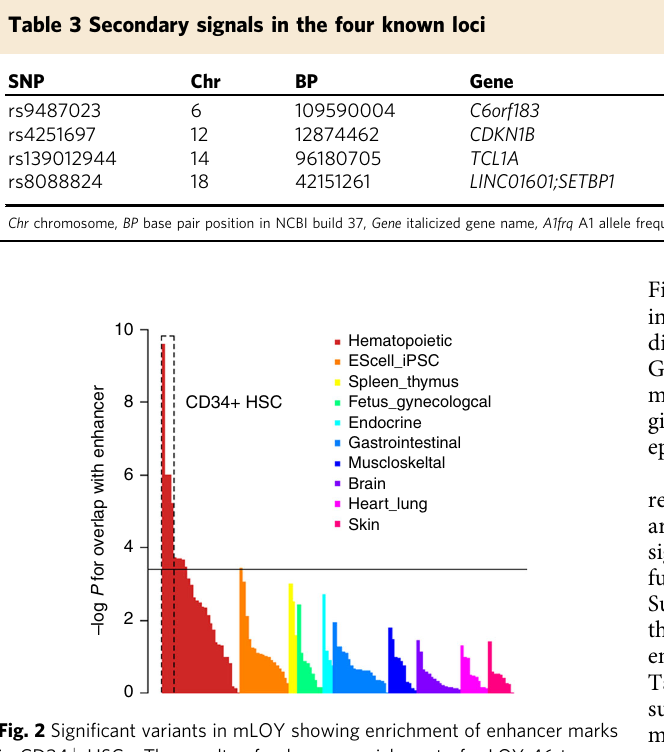
Fig. 2 Signi fi cant variants in mLOY showing enrichment of enhancer marks in CD34 + HSCs. The results of enhancer enrichment of mLOY 46 top markers in 127 cell types calculated by Haploreg are indicated. Cell groups are shown in different colors. The results are sorted by cell groups and P -values. The horizontal solid line indicates signi fi cant level of P -value based on Bonferroni ’ s correction (empirical P = 0.000394